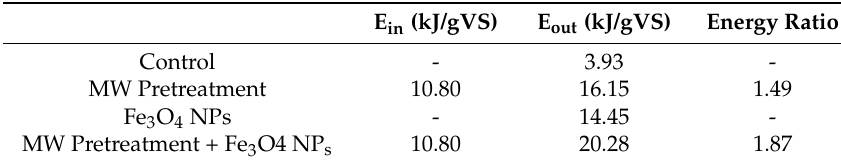
Table 2. Results for Energy